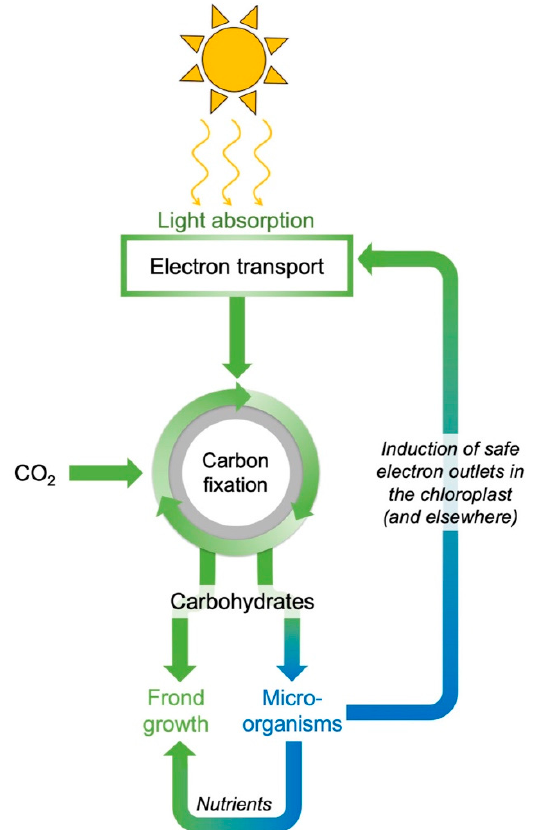
Figure 10. Schematic depiction of the effect of microorganisms in counteracting feedback inhibition of photosynthesis by (i) acting as a sink for carbohydrates, (ii) improving plant nitrogen content in support of new growth (as well as photosynthetic capacity), and (iii) indirectly and directly promoting safe electron outlets in chloroplasts and elsewhere.